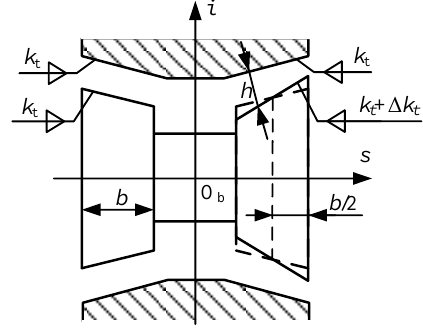
Figure 3. Schematic of bearing taper error.